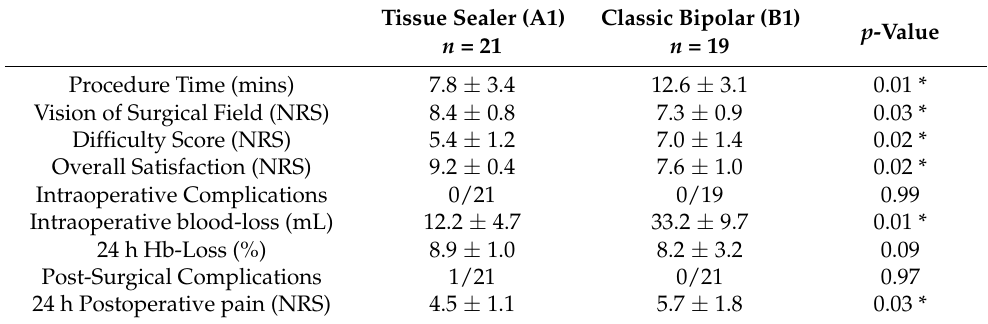
Table 2. Primary and secondary outcomes for laparoscopic salpingo-oophorectomies.